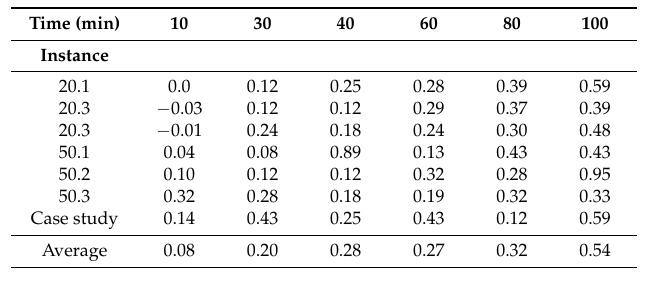
Table 13. Percentage difference in cost between DE and MDE using 10, 30, 40, 60, 80, and 100 min as the stopping